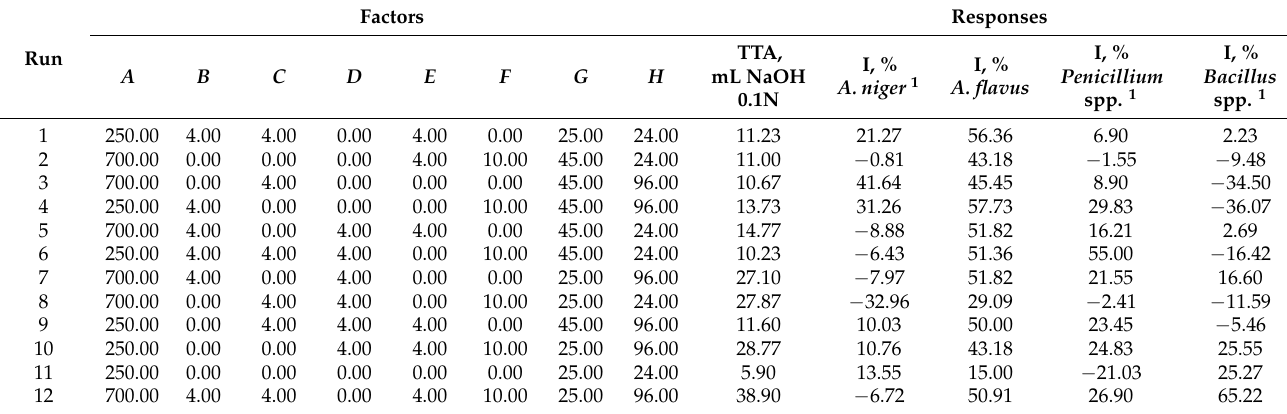
Table 3. Experimental results of the total titratable acidity (TTA) and inhibition ratio ( I , %, defined by the Equation (2)) obtained by Plackett–Burman Design (PBD) analysis. The meaning of the factors A to H is given in Table 1.